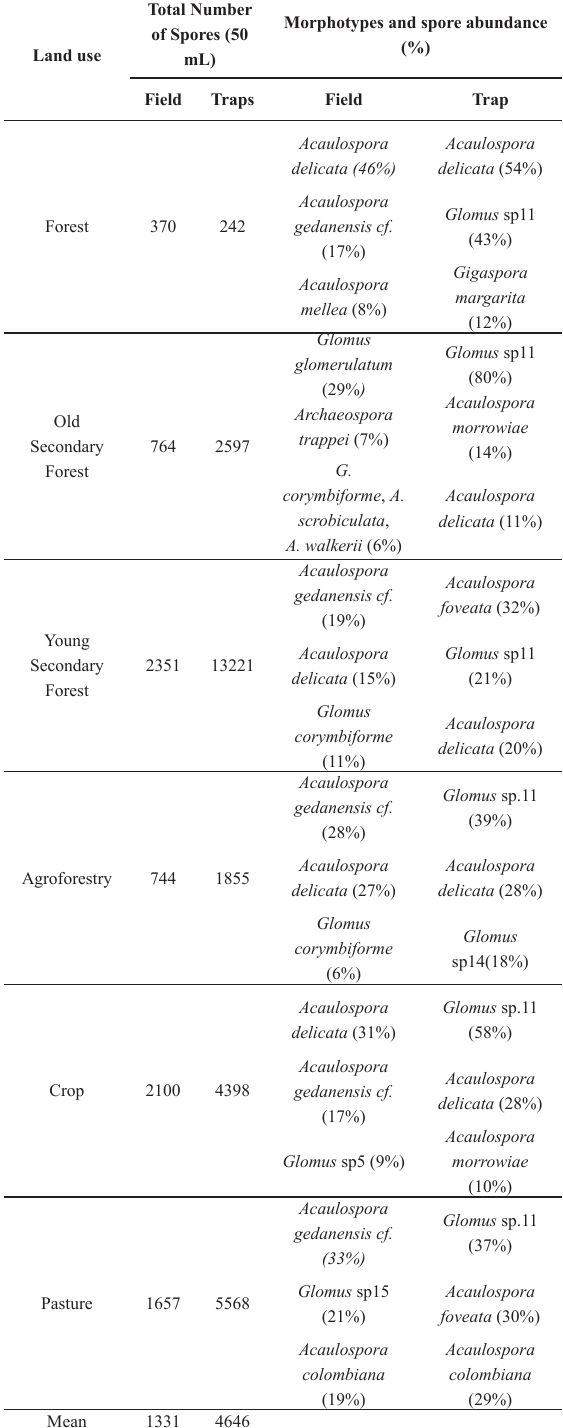
Total number of spores (in 50 mL soil) recovered in fi eld and traps and species with the highest relative abundance (%) from distinct land uses in western Amazon.